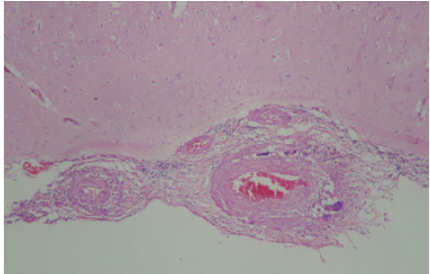
Figure 4: Brain MRI was performed with evidence of intracerebral hematoma with right frontal brain